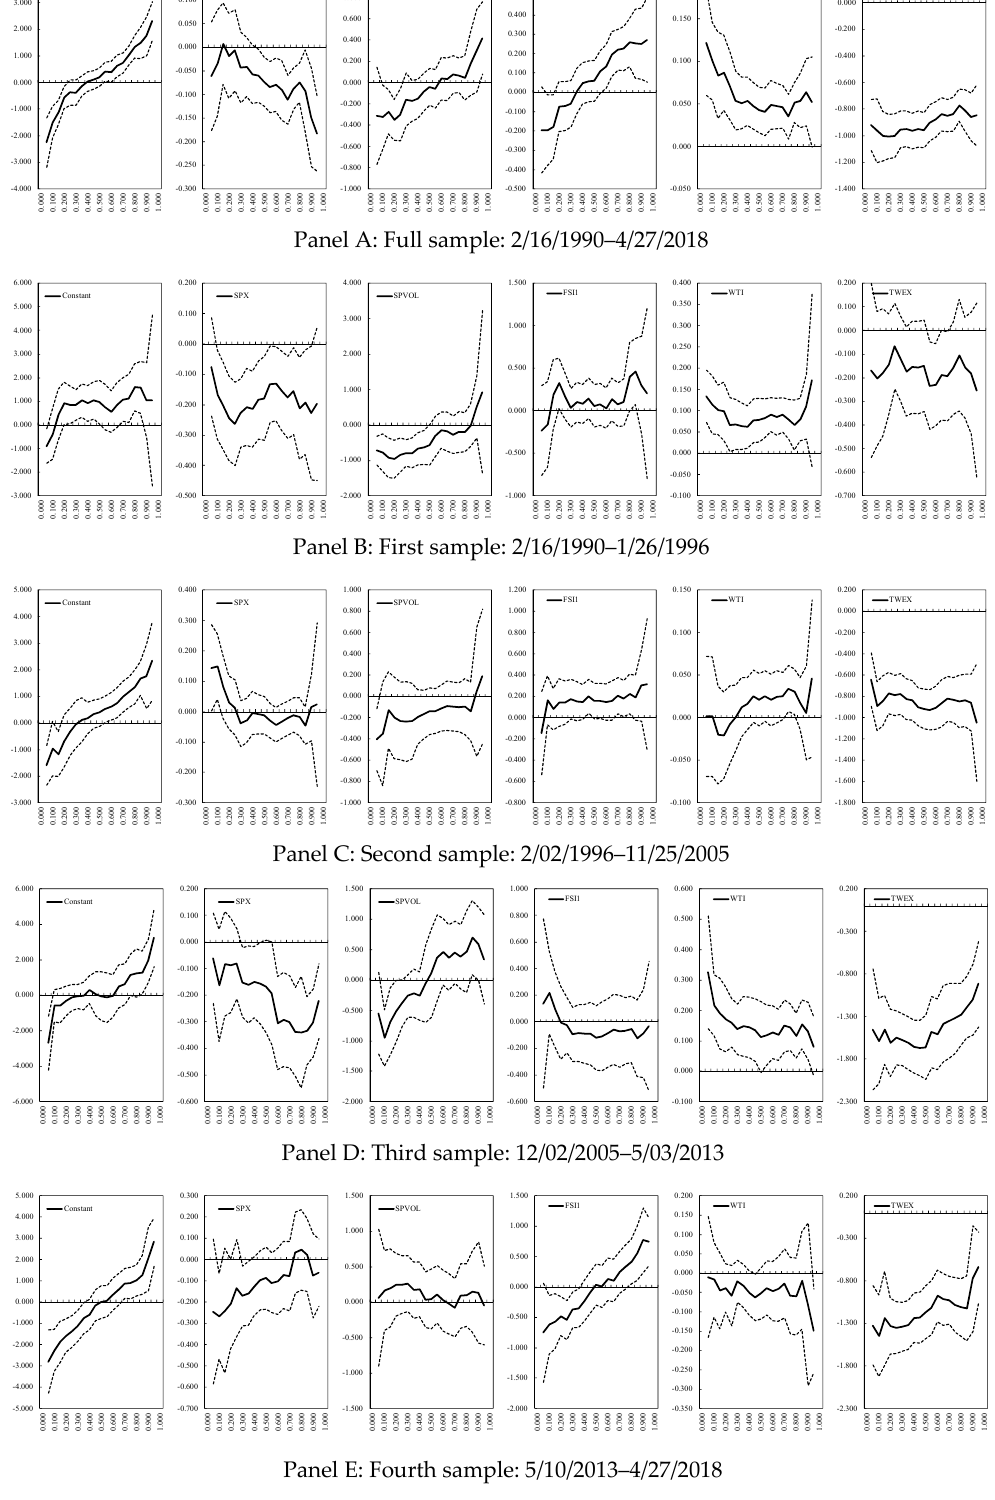
Figure 3. This graph illustrates the quantile process of gold return. For each panel, from left to right, we show the evolutions of coefficient on constant term, S&P 500 index return, S&P 500 Index return volatility, financial market stress, crude oil return, and the appreciation/depreciation rate of the trade ‐ weighted US dollar. The dotted lines in the figure represent the 95% confidence intervals. As shown in Panel A of Figure 3, Gold return is negatively correlated with the S&P 500 Index return and is significantly negative from the intermediate quantiles to the upper quantiles. The higher the quantile, the larger the coefficient increases in absolute value. The result means that gold return would rise largely when the stock return falls. However, the slope equality test at the lower and upper quantiles based on the Wald test cannot reject the null hypothesis of equality at 5% significance level, implying that dependence structures do not differ across quantile levels. Looking at the relationship with the stock return volatility, the estimated coefficient is negative for lower quantiles and positive for upper quantiles, implying that the gold return responds to the stock return volatility asymmetrically. The result that gold return rises as the stock market volatility increases is considered to reflect the investor behavior of divesting from stocks as a risky asset and demanding gold as a safety asset. Applying the Wald test, we can reject the slope equality hypothesis at 5% significance level, suggesting that dependence structures are different across quantile levels. Analogous to stock return volatility, for the financial market stress, the estimated coefficient is negative for the lower quantiles and positive for the upper quantiles, indicating asymmetric response of gold return to the degree of financial market stress. The Wald test clearly rejects the null hypothesis of equality at 1% significance level again. In other words, when the general financial market tightens, gold returns rise, and this result reflects the flight ‐ to ‐ quality behavior of investors. Regarding the relationships with crude oil and the value of the US dollar, no noticeable difference is found from the results using OLS and robust regression. That is, the coefficient is significantly positive from lower to upper quantiles for crude oil, whereas it is significantly negative from lower to upper quantiles for the US dollar. The latter result is consistent with the findings of Miyazaki and Hamori (2016). In summary, quantile regression allows us to clarify the responses of gold return on stock returns, stock market volatility, and financial market tightness in the tails of the distribution. Such relationships were not captured by OLS and robust regressions. In the following, we present detailed results for each subsample period.